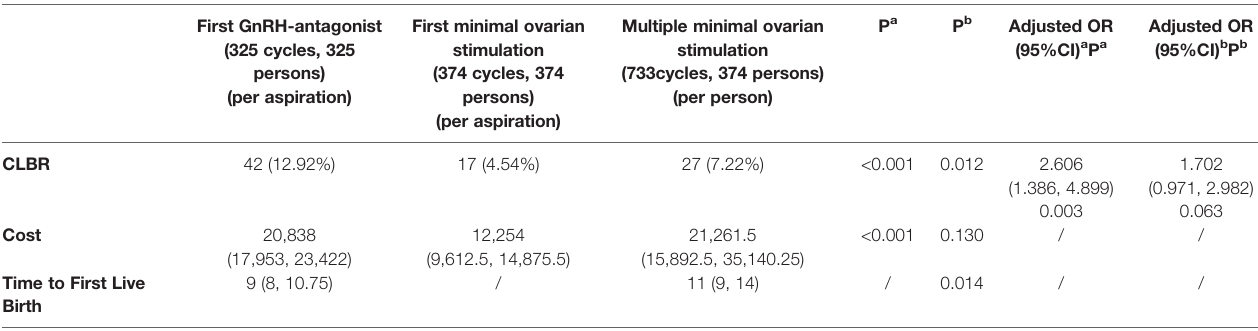
TABLE 3 | Clinical outcomes according to different protocols.